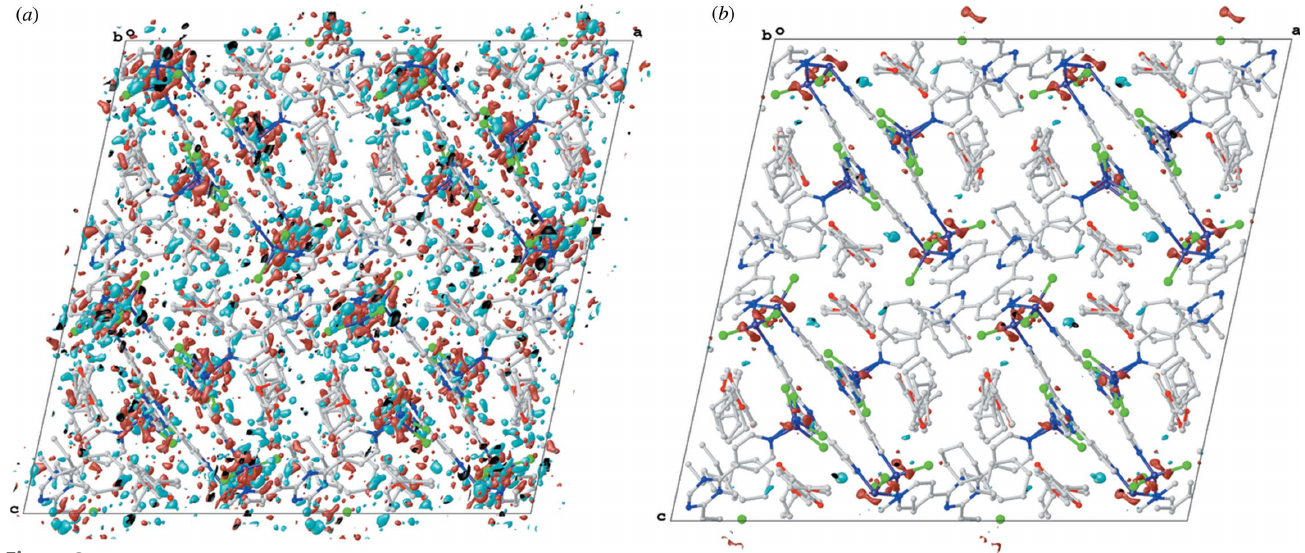
Figure 2 Residual electron density map (iso value: 0.5 e A˚ (cid:6) 3 ) for measurement 1: ( a ) Cu K (cid:4) and ( b ) Cu K (cid:2) measurements with the sponge scaffold, analyte and solvent in ball and stick representation along the b direction. Hydrogen atoms have been omitted for